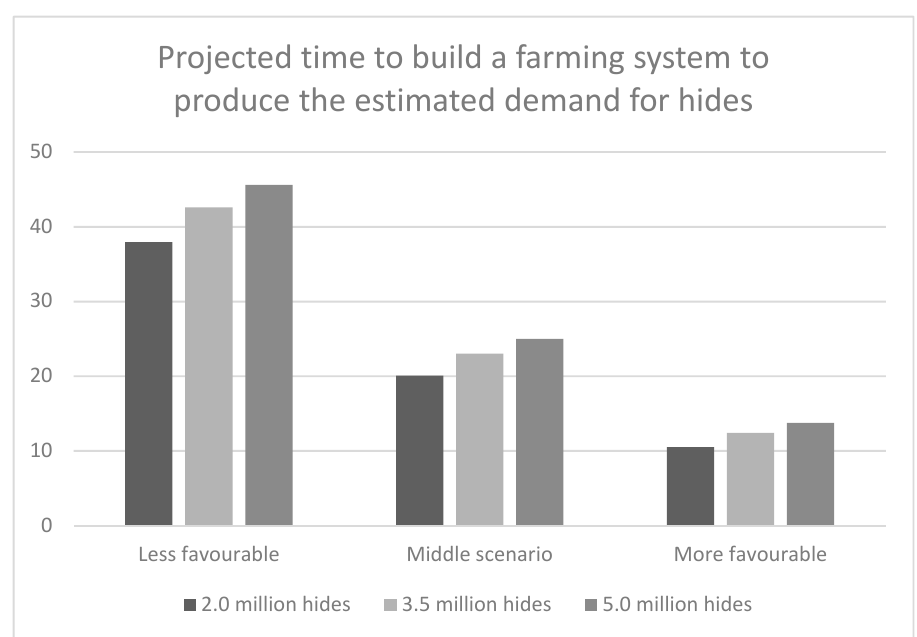
Figure 4. Number of years until the target hides of 2.0, 3.5 and 5.0 million per annum are reached under the three scenarios.